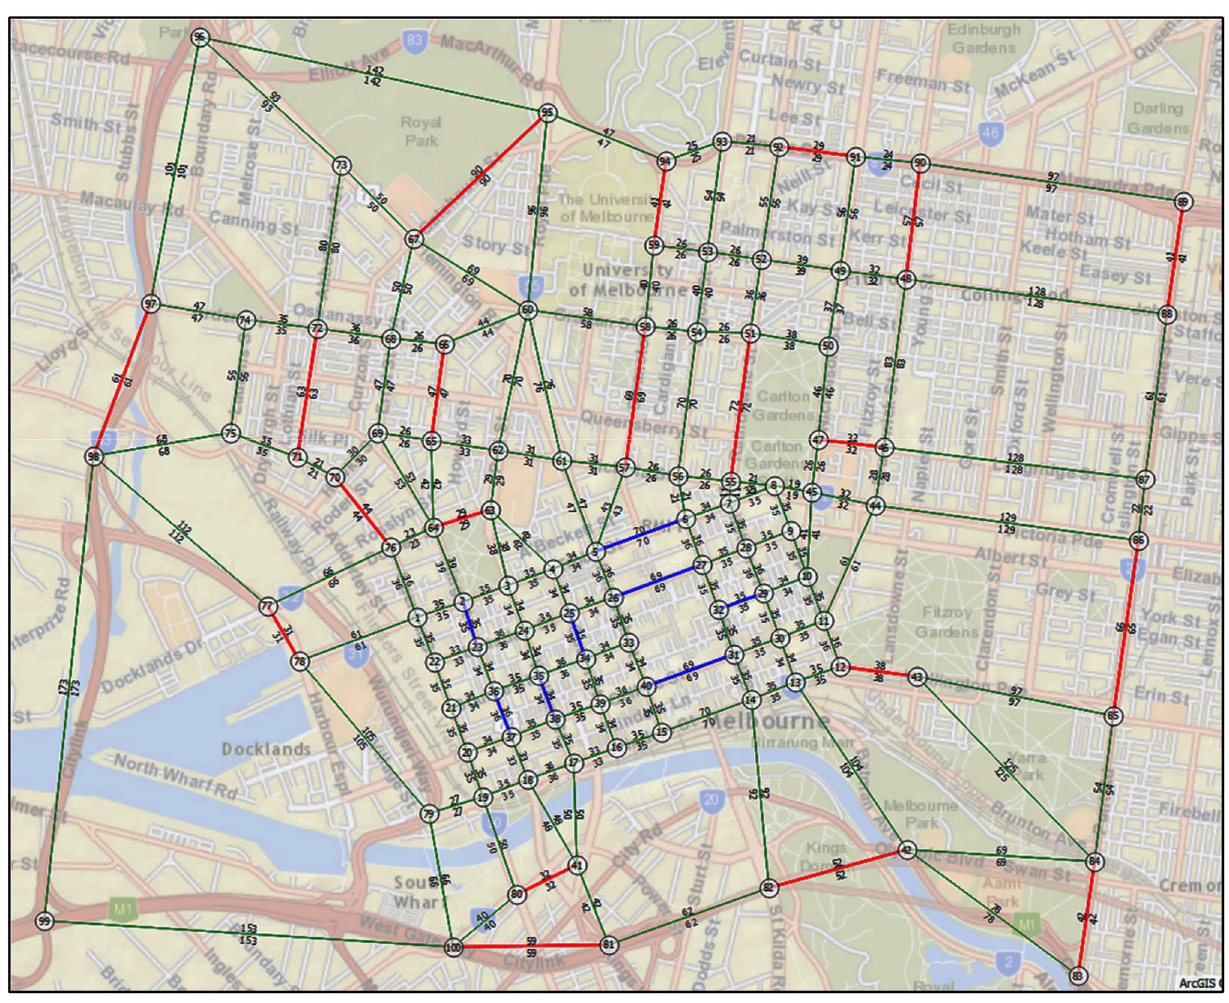
Fig. 8 Melbourne’s central region: the red and blue colored links represent pickup/dropout points and places of interests, respectively. The numbers on the links indicate the traversing time (per 0.01 unit of